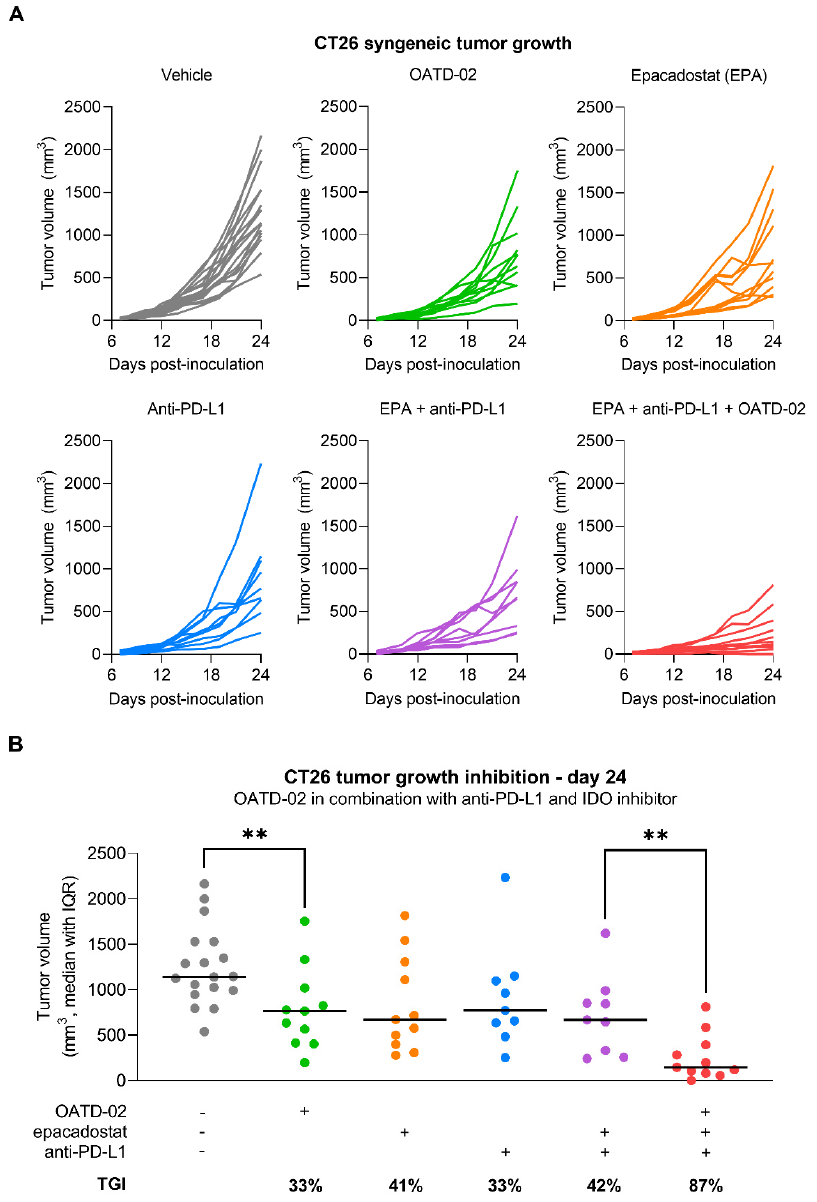
Figure 3. OATD-02 shows superior efficacy in the CT26 tumour model when combined with immune checkpoint inhibitor (anti-PD-L1 antibody) and IDO inhibitor (epacadostat). ( A )—BALB/c mice were inoculated with CT26 cells and upon 24 h dosed with OATD-02 (50 mg/kg, PO, BID) or epacadostat (30 mg/kg, PO, BID) till the end of the experiment; anti-PD-L1 antibody was administered at 2.5 mg/kg (IP, QD at days: 8, 10, 12, 14 and 16); ( B )—final measurements of tumour volumes were taken at day 24 post-inoculation and TGI was calculated (** 0.0042 < p < 0.0060, U Mann–Whitney test).